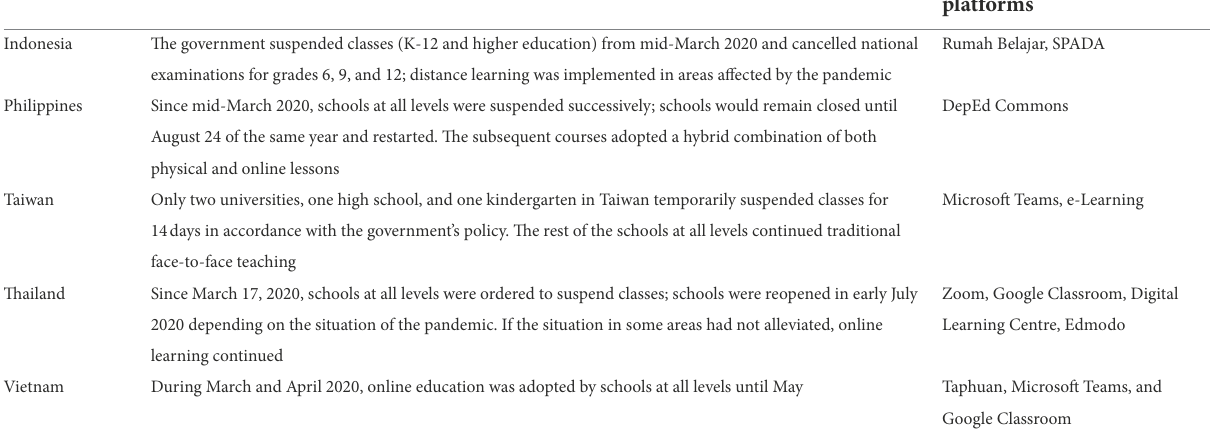
TABLE 1 Solutions adopted by educational institutes in five countries during the COVID-19 pandemic.